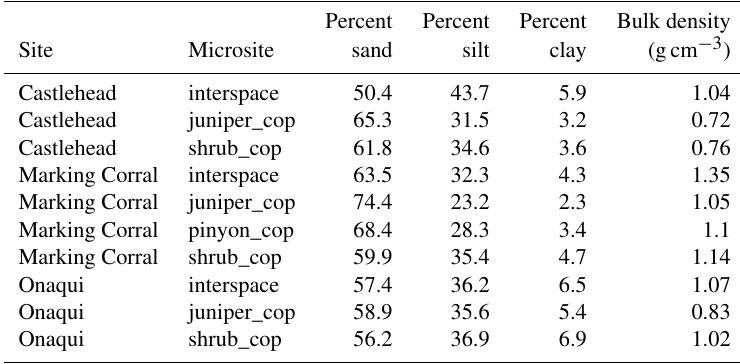
Table 4. Soil texture and bulk density variables and data structure for those measures for all study sites. Abbreviations in the table example are as follows: juniper_cop refers to juniper coppice microsites, shrub_cop refers to shrub coppice microsites, and pinyon_cop refers to pinyon coppice microsites.